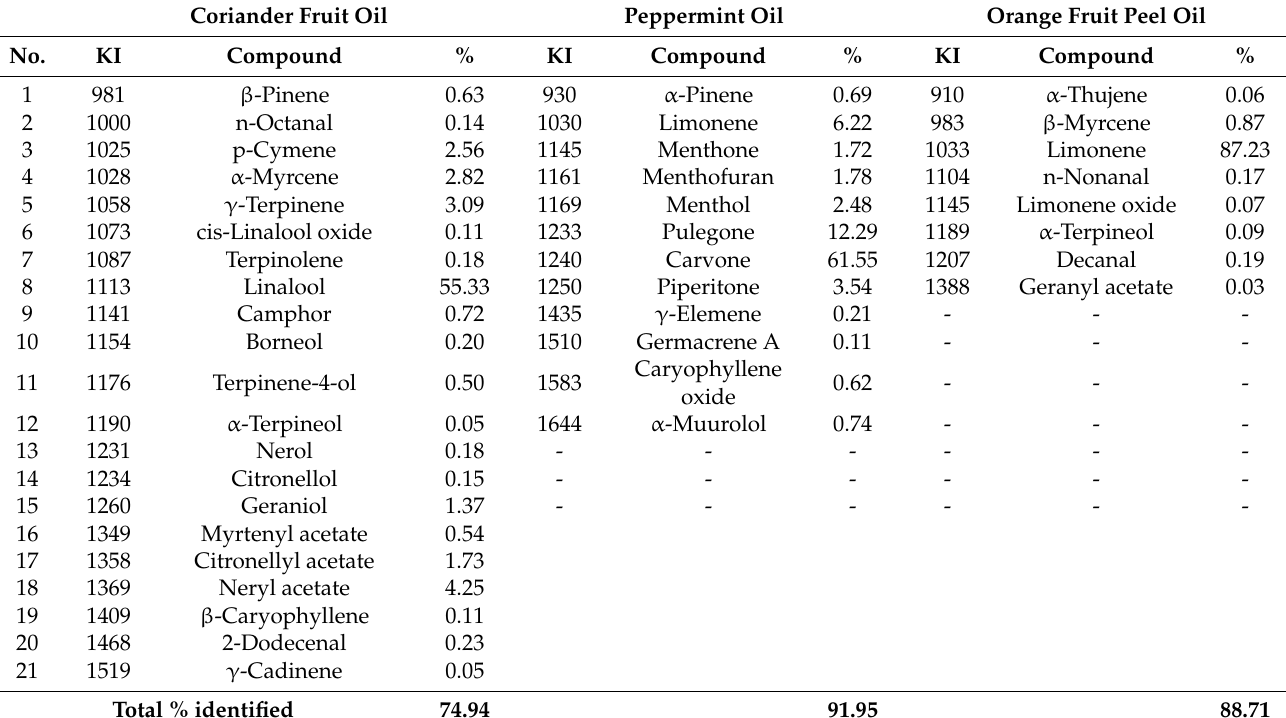
Table 2. Chemical components of coriander fruit, peppermint leaf, and orange fruit peel EOs. Coriander Fruit Oil Peppermint